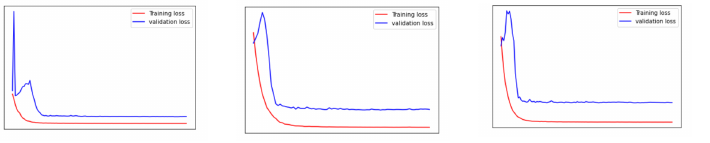
Figure 10. Training and validation loss of proposed classifiers using different distance